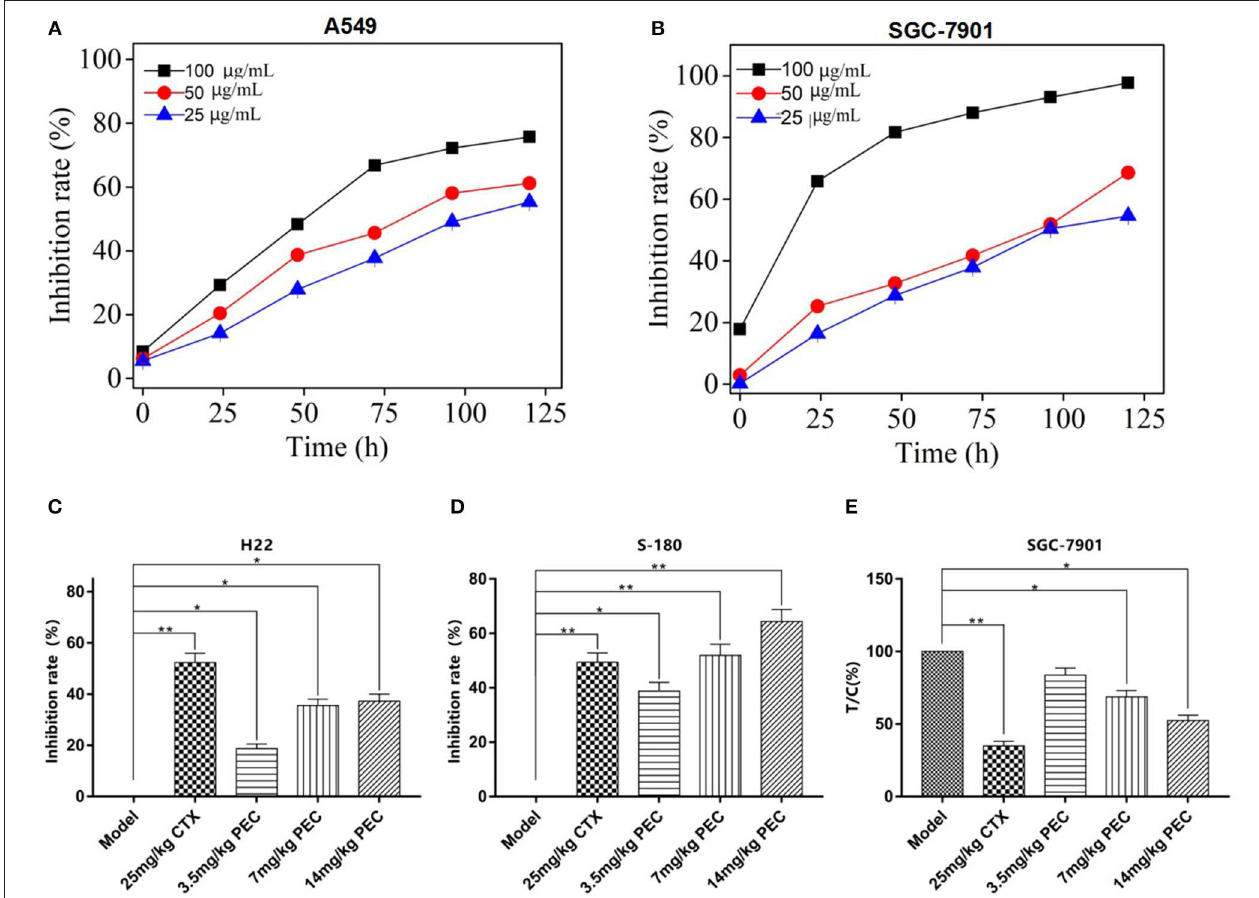
FIGURE 2 | Inhibitory effects of PEC on growth of (A) SGC-7901 and (B) A549 cells with different time ( ¯ x ± s, n = 4). Inhibitory effects of PEC on (C) H22 and (D) S-180 xenograft tumors in mice ( ¯ x ± s, n = 10). (E) Inhibitory effects of PEC on transplanted SGC-7901 tumors in nude mice ( ¯ x ± s, n = 6). Compared with model group: * P < 0.05, ** P < 0.01. Tumor inhibition rate (%) = (mean tumor weight in the model group – mean tumor weight in the administration group)/average tumor weight in the model group ×